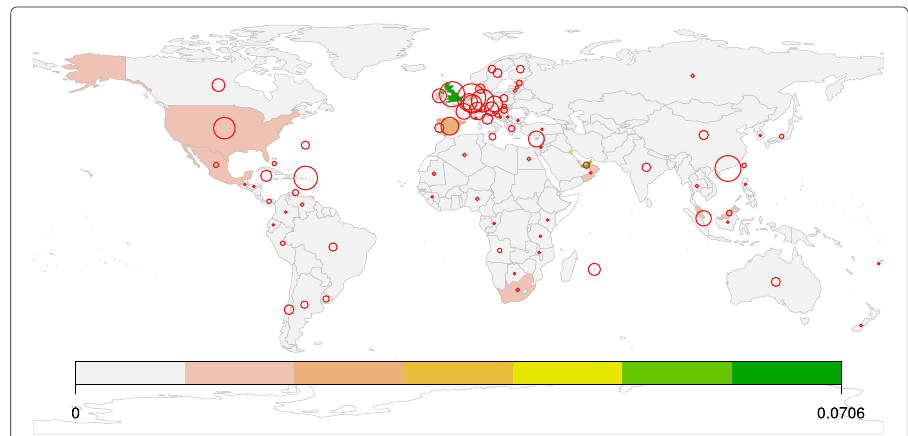
Fig. 13 “Conduit” companies and Treaty shopping. The size of the circles indicates the number of “conduit” companies and the depth of the color indicates the possibility to be used for treaty shopping by the jurisdiction